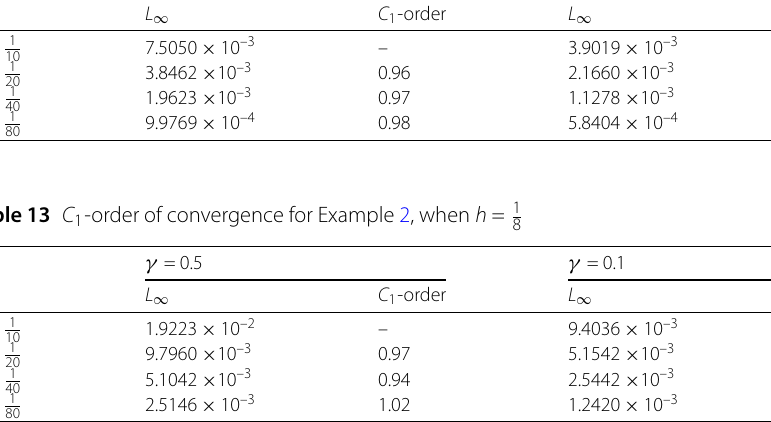
Table 12 C 1 -order of convergence for Example 1, when h = 1